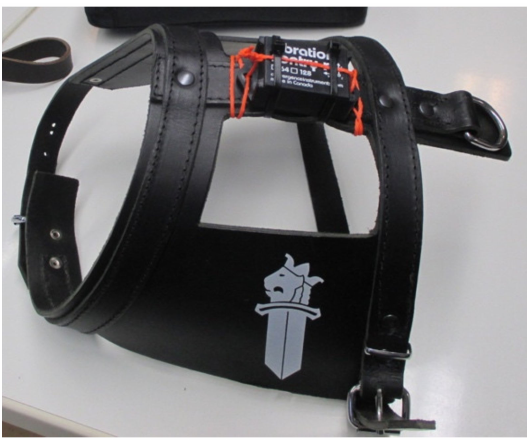
Figure 3. Three-dimensional accelerometer attached to dogs’